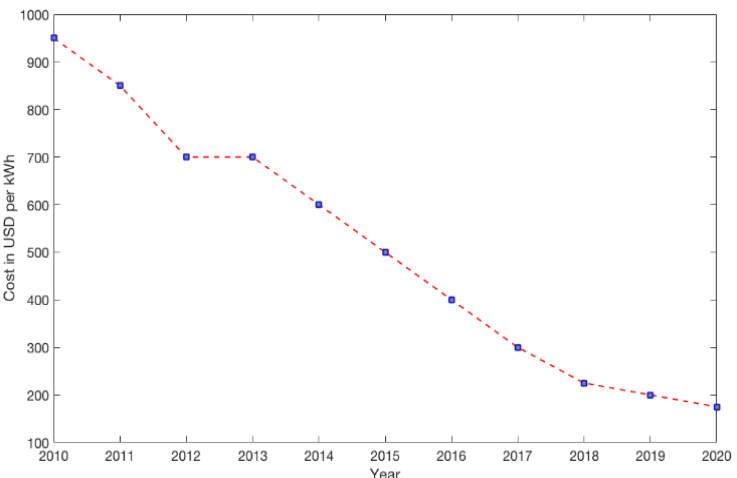
Figure 12. Li-Ion battery cost per kWh over years from 2010.